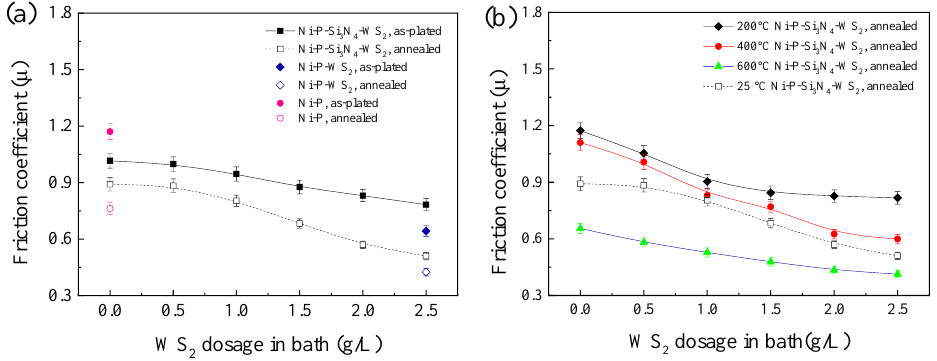
Figure 5. Dependence of the friction coefficient of Ni-based coatings on WS 2 dosage in bath: ( a ) at room temperature and ( b ) at 200, 400, and 600 °C (the data at R.T. are also included for comparison).